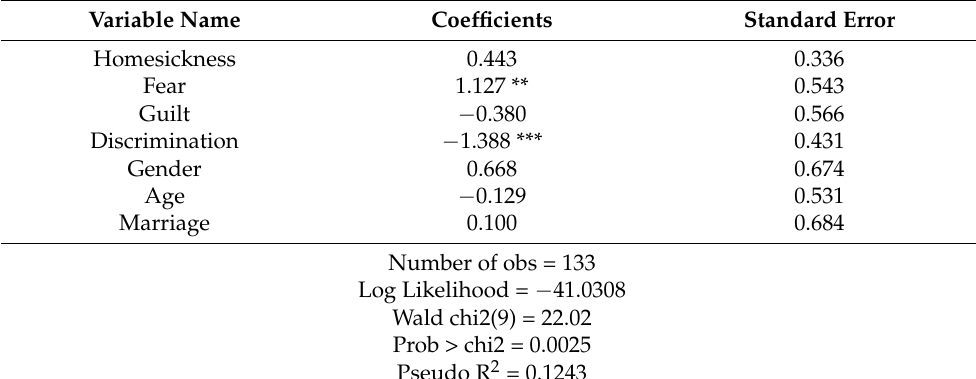
Table 4. Logit model for the perception of being safe in China or